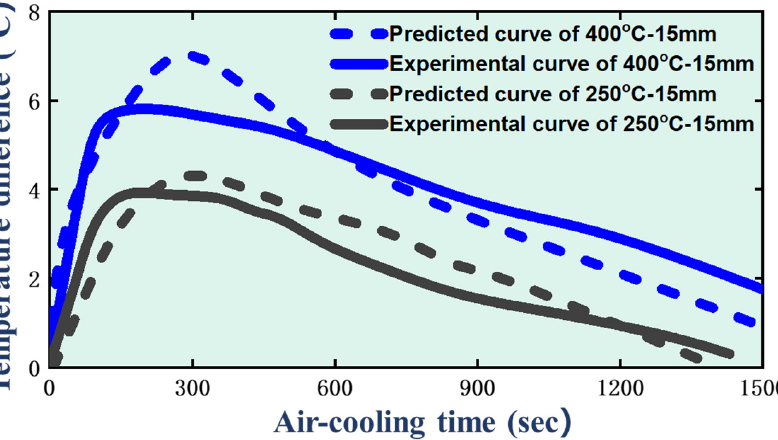
Figure 8. Relation between the predicted and experimental curves of ∆ T width variation at 400 ◦ C– 15 mm and 250 ◦ C–15 mm